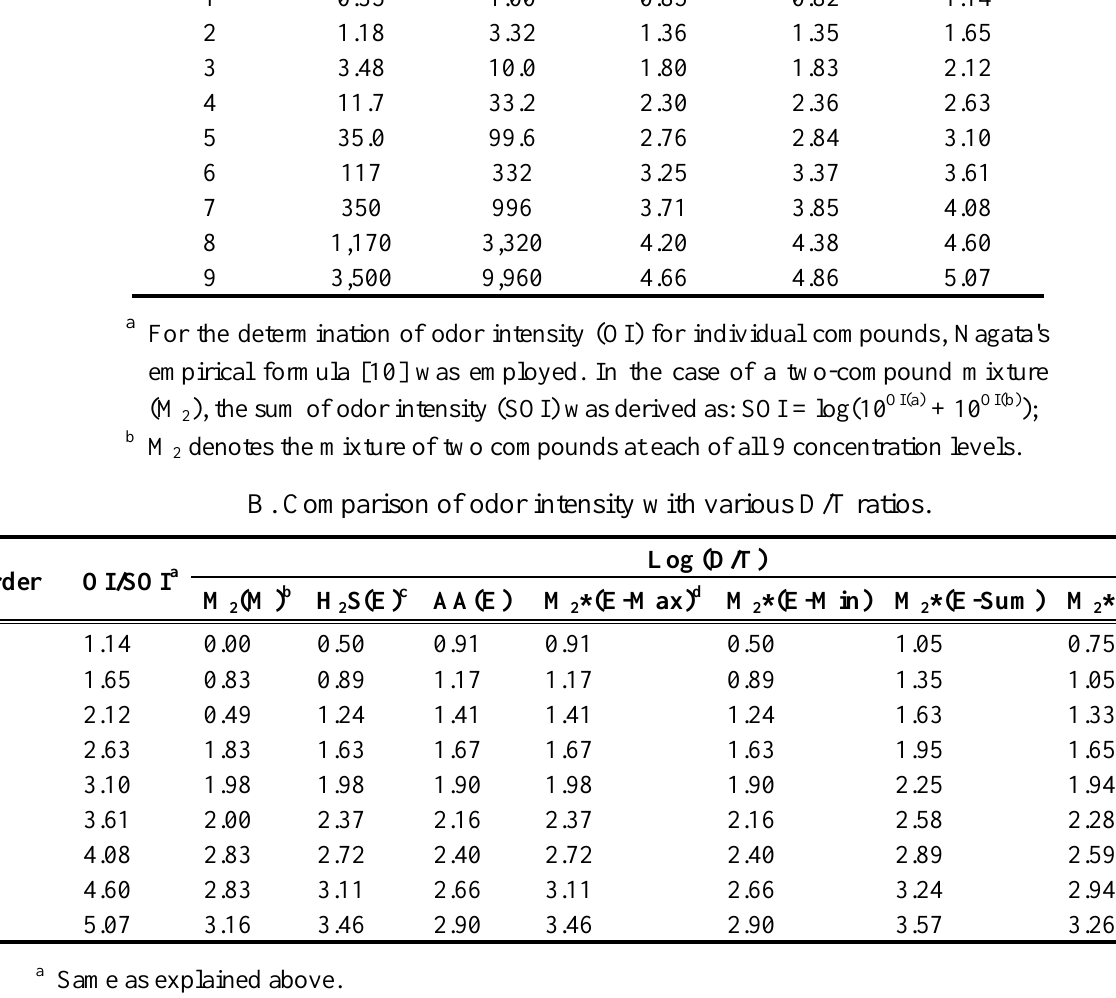
Table 3. Relationship between odor intensity and dilution-to-threshold (D/T) ratios for an odorant mixture consisting of two individual compounds (M